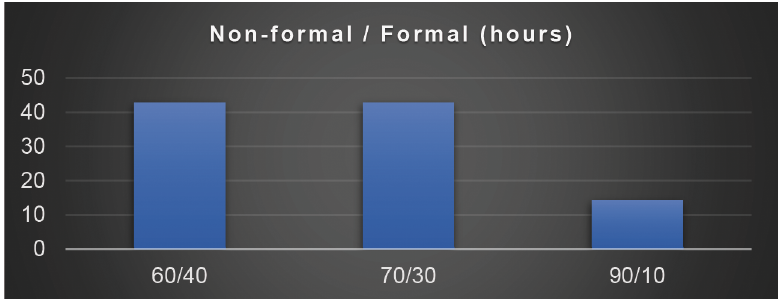
Figure 3. Relationship of hours invested in non-formal and formal